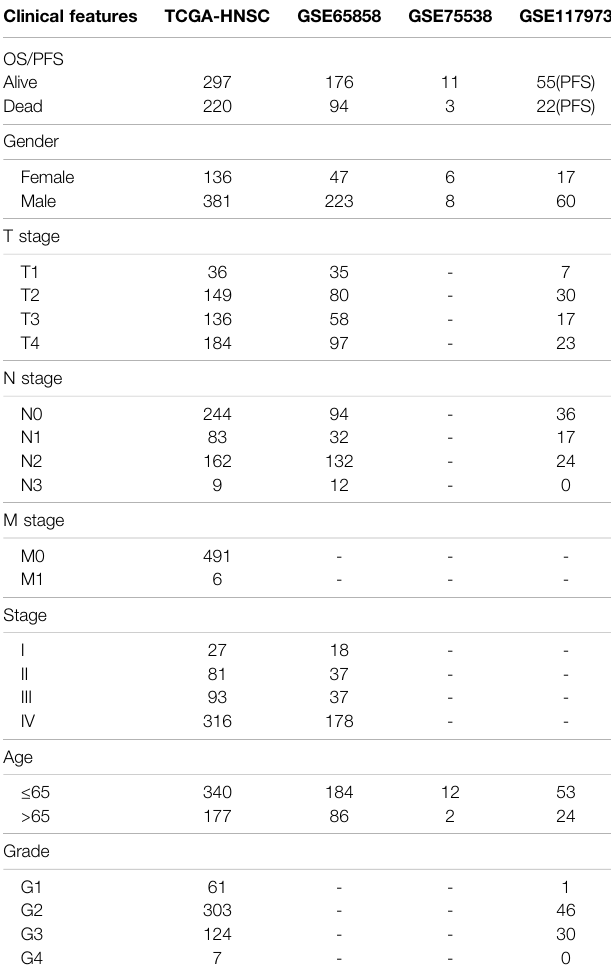
TABLE 1 | The clinical information of HNSCC patients from different